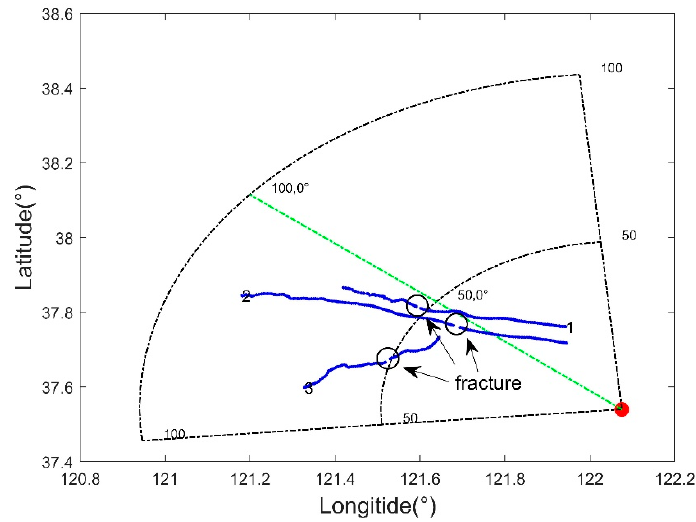
Figure 7. Broken tracks of three vessels detected by HF radar. The red dot represents shore-based HF radar. The black corner sectors indicate the detection area of the HF radar. The blue lines indicate the moving trajectories of the three vessels, labeled 1, 2 and 3. The black oval is the mark of the fracture.